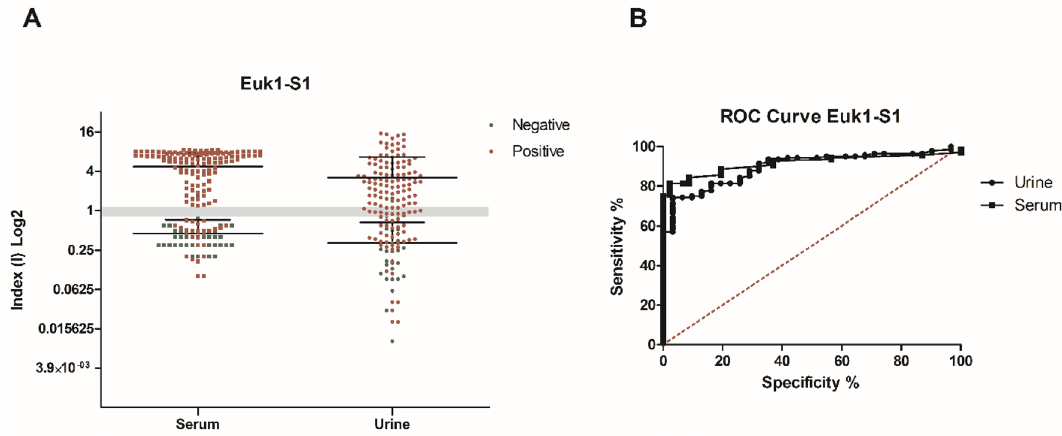
Figure 1. Comparative diagnostic performance of rSARS-CoV-2 Euk1-S1 protein with patient urine and serum samples. ( A ) ELISA assays were done using positive samples (n = 140 urine and n = 140 serum) from COVID- 19 patients with previously positive qRT-PCR and negative samples (n = 31 urine and n = 46 serum). The mean of each group is shown and the gray band indicates indeterminate values for each sample, while index values below the range (< 0.8) are negative and values above (> 1.1) are considered positive. ( B ) Receiver Operating Characteristic (ROC) curves were constructed using the individual index (I) value for each sample, to obtain sensitivity, specificity and area under the curve values.